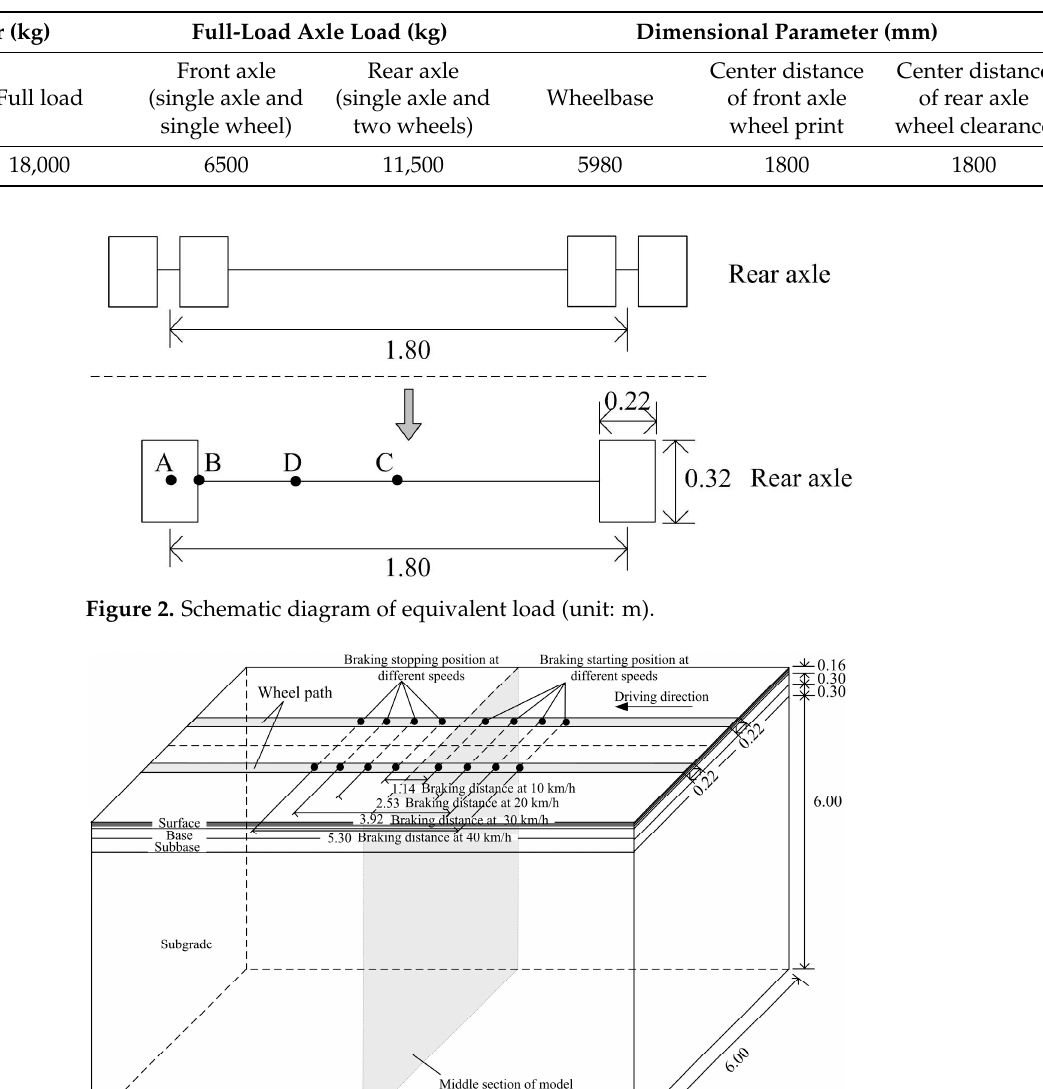
Table 5. Parameters of the BRT bus.